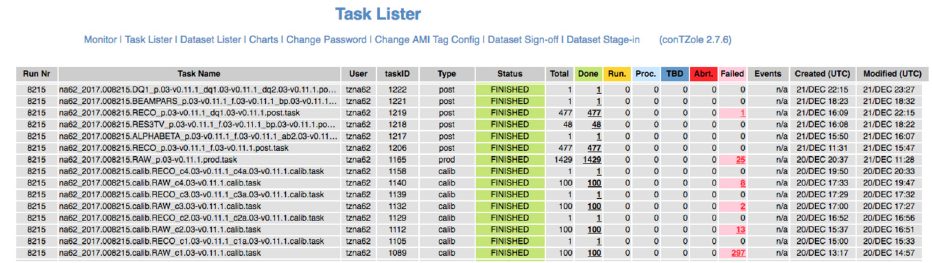
Figure 5. A screenshot of the web interface to the NA62 Tier-0 production